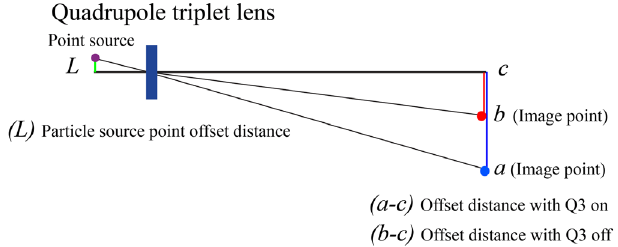
FIG. 2. Schematic diagram of focusing with the quadrupole triplet lens when the beam source has a displacement from the beam center line in the y direction. Triplet lens (Q3 on) and doublet lens (Q3 off) have different amplification